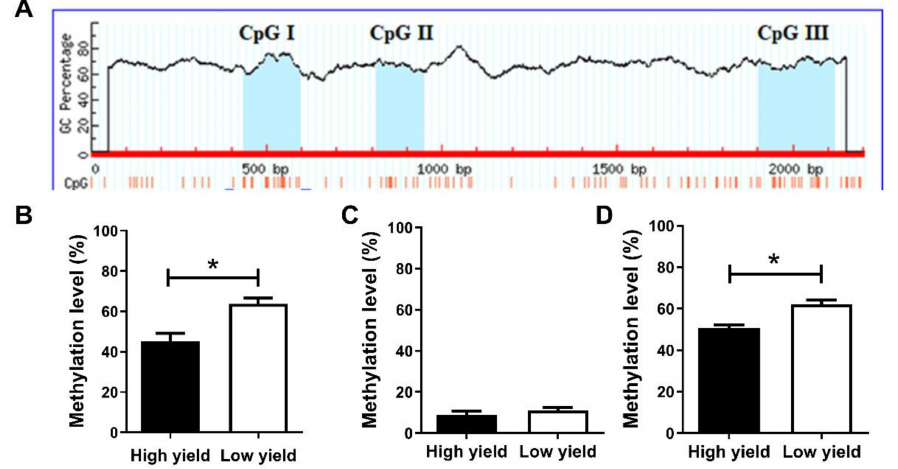
Figure 6. Methylation levels of three CpG islands in the high and low yield groups. ( A ) distribution of CpG islands in rabbit KRT17 promoter. Methylation levels of ( B ) CpG I; ( C ) CpG II; and ( D ) CpG III islands in the high and low yield groups, respectively. * p <